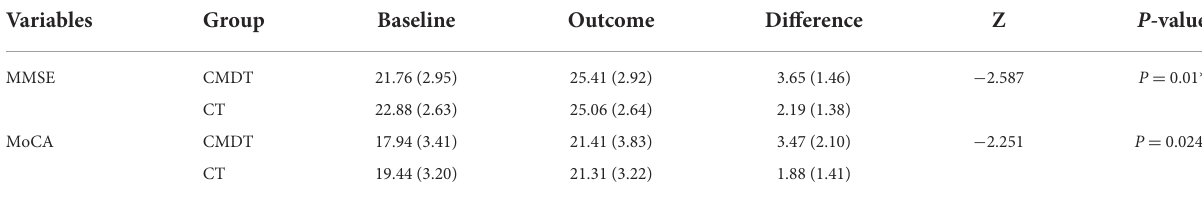
TABLE 2 Estimated mean change (SD) and statistical significance in primary outcome